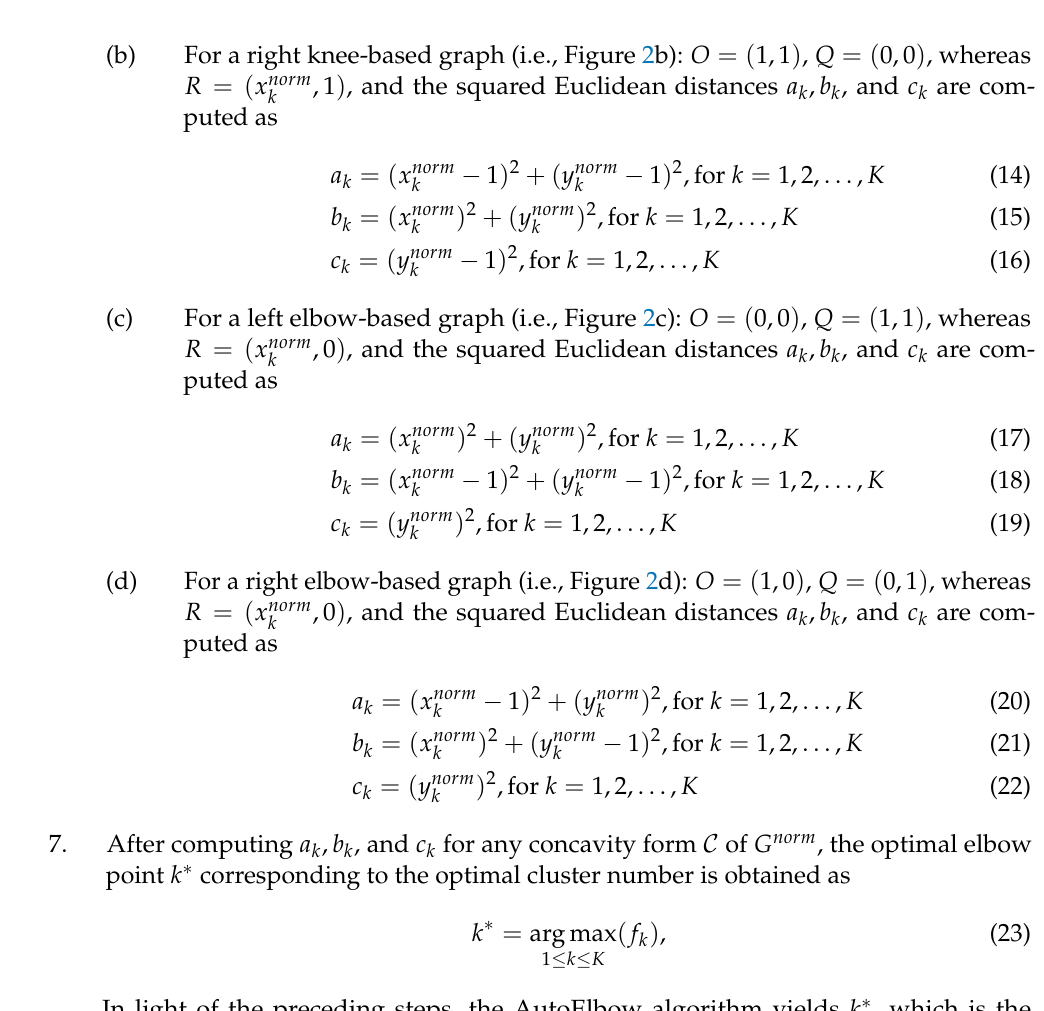
(b) For a right knee-based graph (i.e., Figure 2b): O = ( 1, 1 ) , Q = ( 0, 0 ) , whereas R = ( x norm , 1 ) , and the squared Euclidean distances a k , b k , and c k are com- k puted as